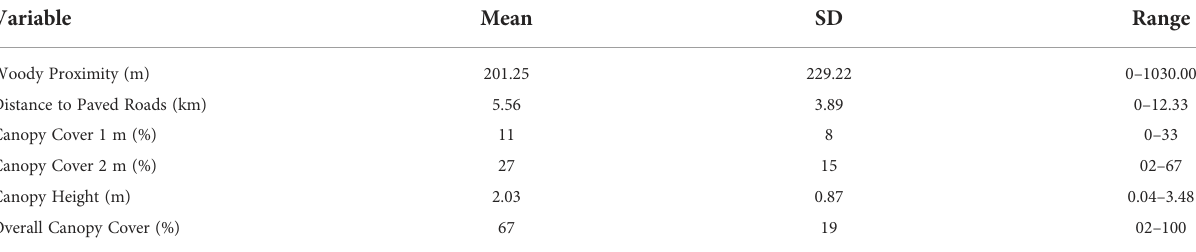
TABLE 1 Summary of the mean (SD) and range of site-level metrics used to model ocelot ( Leopardus pardalis pardalis ) encounter probabilities (g0, s ) on the East Foundation ’ s El Sauz Ranch in southern Texas, USA from September 2020 to May 2021.